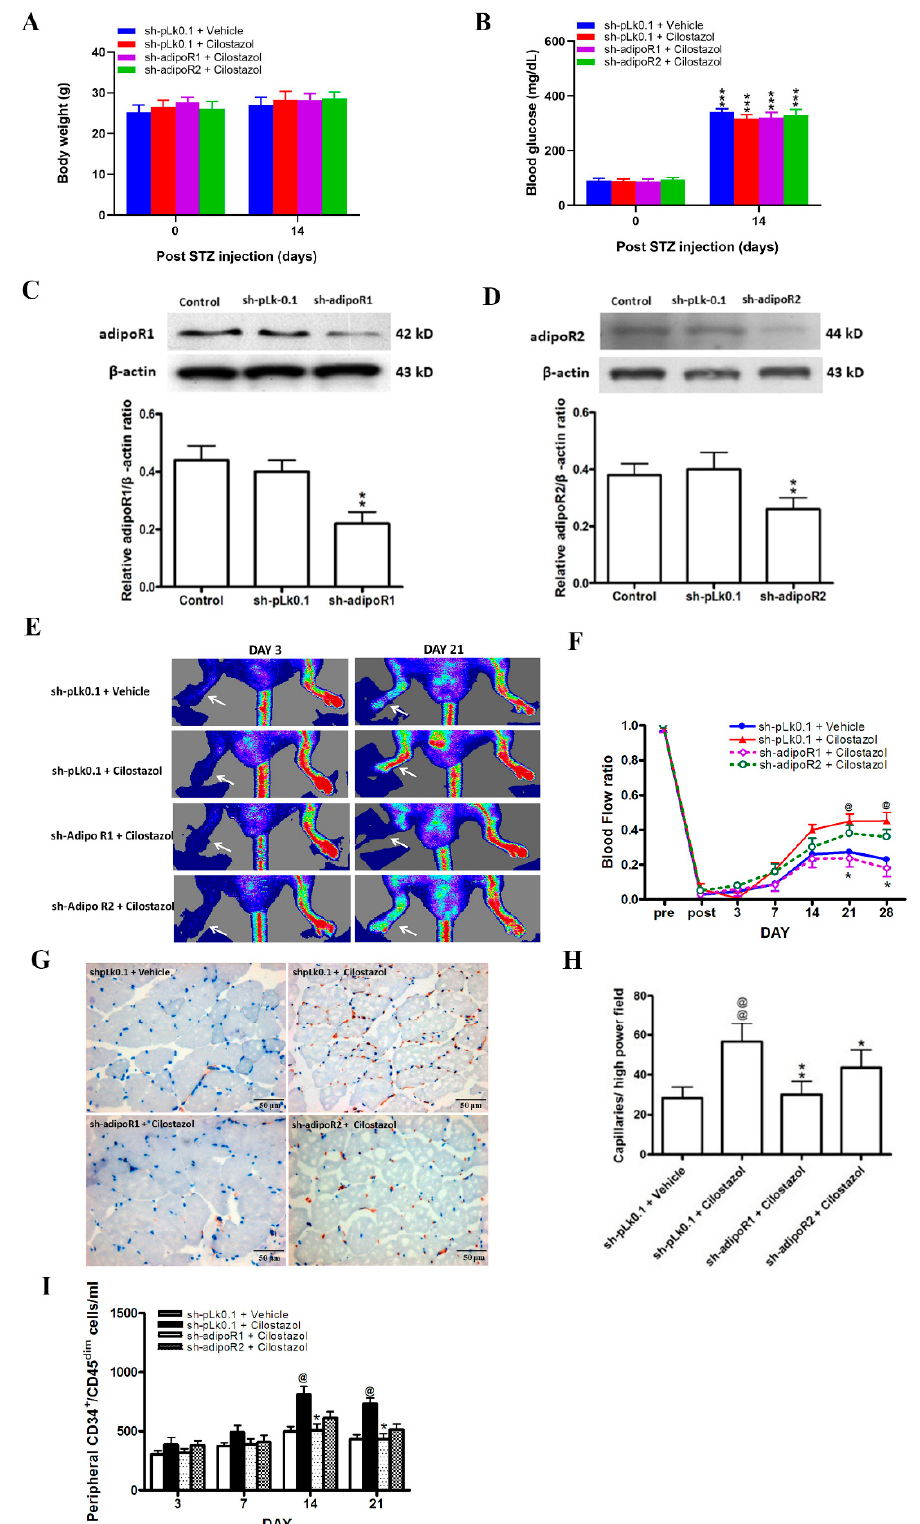
Figure 5. AdipoRs play a pivotal role in the cilostazol-mediated adiponectin angiogenesis in STZ- induced diabetic mice undergoing hindlimb ischemia. STZ-induced diabetic mice were transfected with adipoR1 sh-RNA or adipoR2 sh-RNA to knock down adipoRs. Animals were then injected with cilostazol (30 mg/kg) or vehicle twice daily for one week. ( A ) Body weight and ( B ) plasma